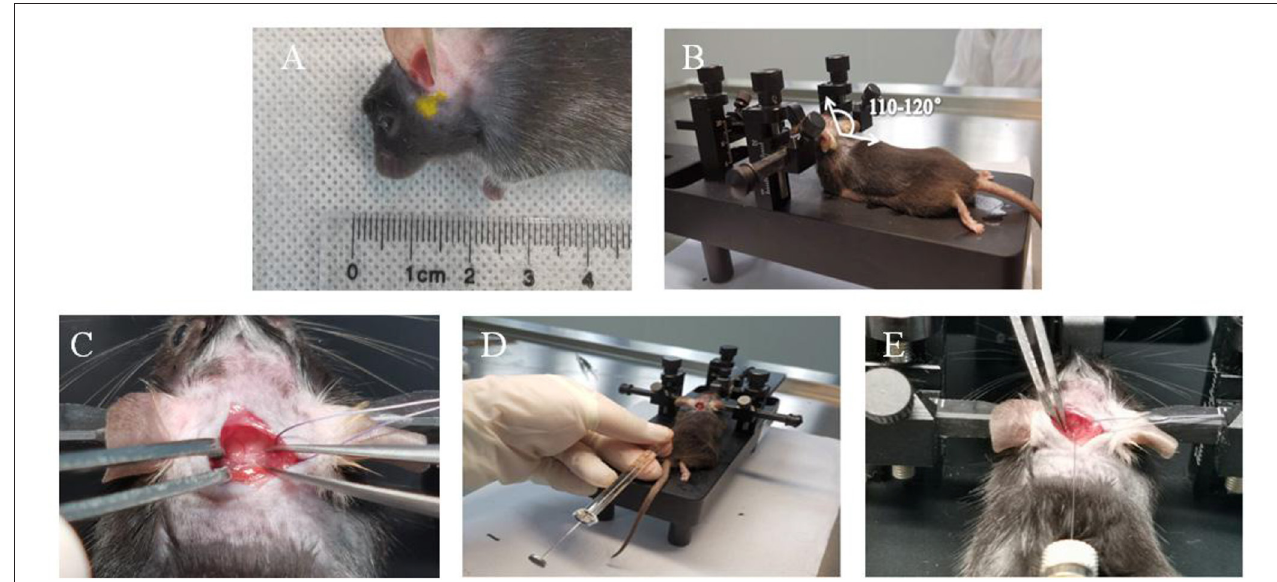
FIGURE 1 | Key operating steps of mouse modeling. (A) The fixed position of the mouse ear cone is the preauricular temporal bone. (B) The angle between the mouse neck and the body is 110–120 ◦ C. (C) Dura mater. (D) Needle holding position. (E) Horizontal needle.